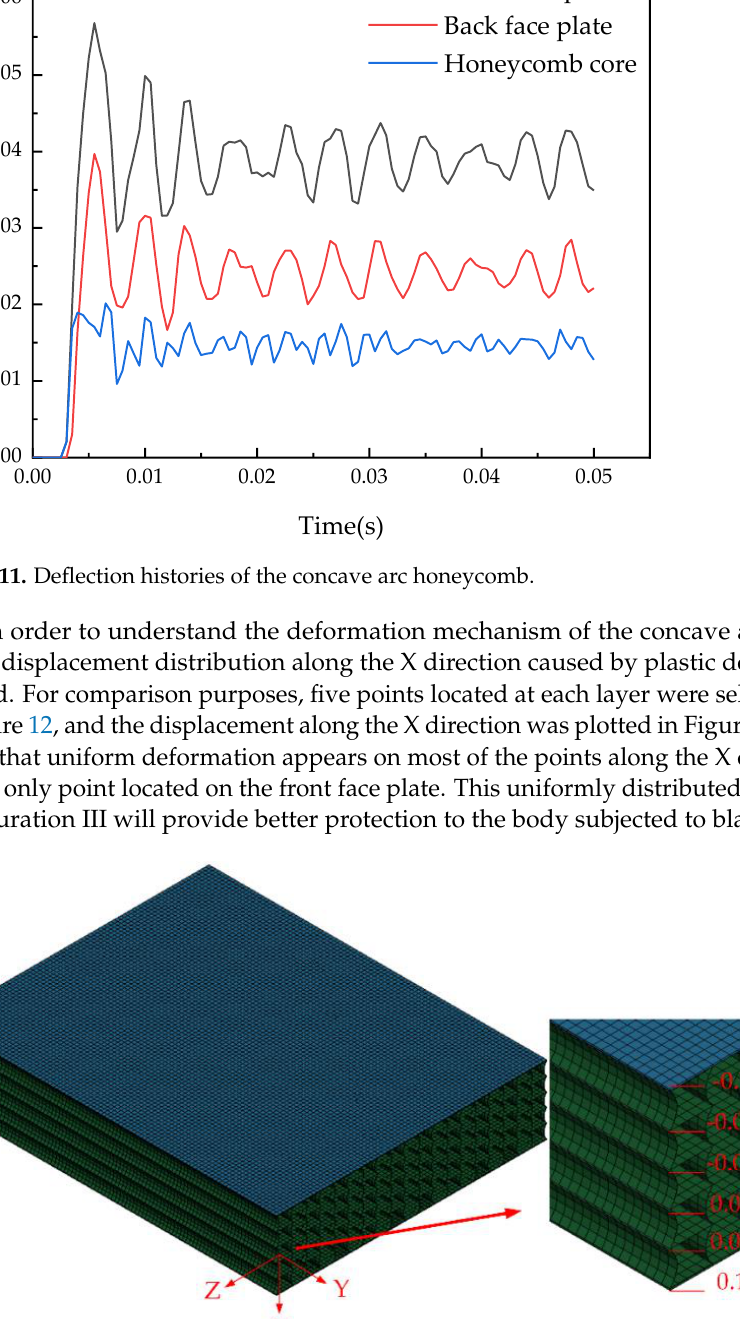
Figure 12. Illustration of the points along the X direction of the concave arc honeycomb.